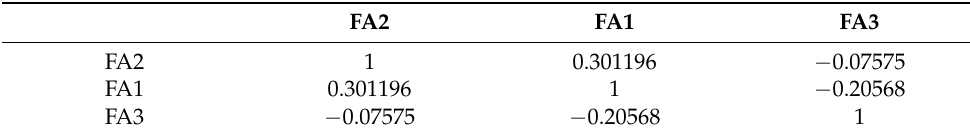
Table 4. Correlations of extracted factors